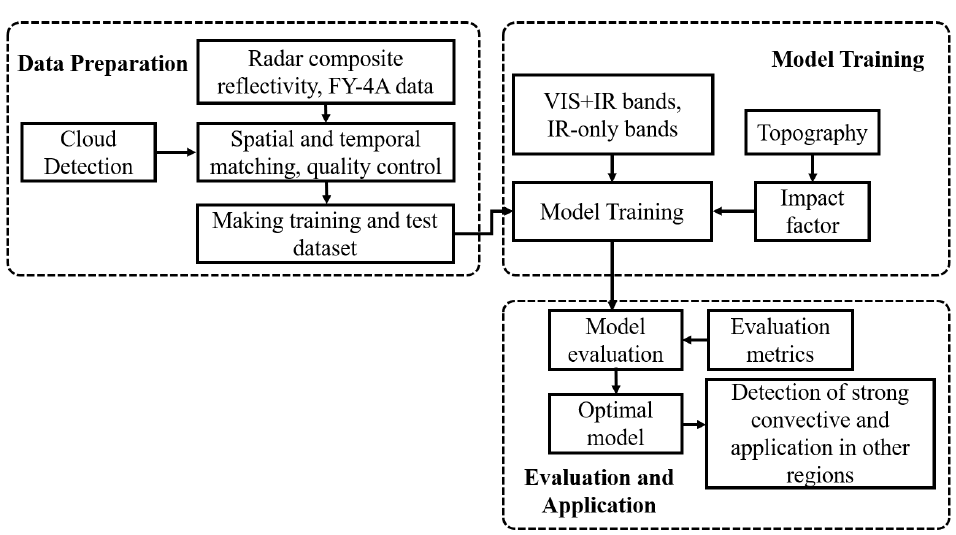
Figure 1. Workflow of CREF reconstruction algorithm based on the DL